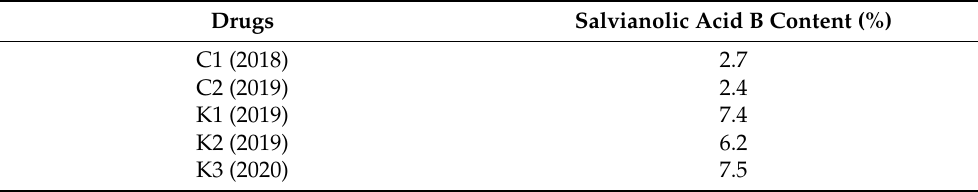
Table 2. The contents of salvianolic acid B in five kinds of Salviae Mitiorrhizae Radix.